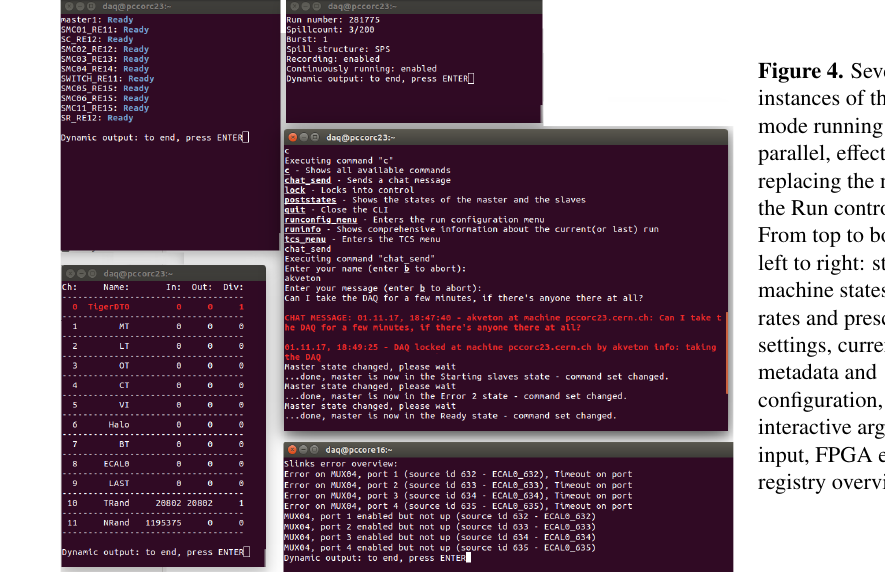
instances of the terminal mode running in parallel, e ff ectively replacing the need for the Run control GUI. From top to bottom and left to right: state machine states,